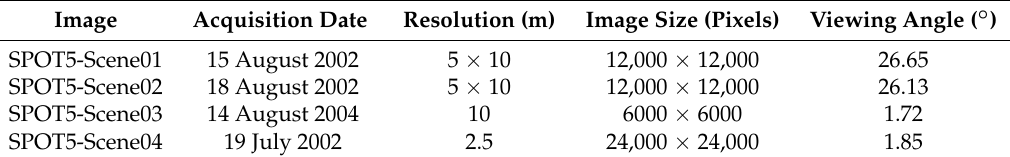
Table 1. Information of four SPOT-5 images.